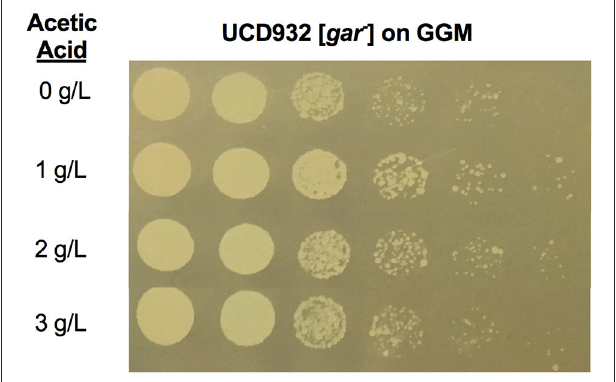
FIGURE 8 | Induction of [ GAR + ] in Saccharomyces by growth in presence of acetic acid is concentration dependent. Growth of Saccharomyces UCD932 [ gar − ] strain when exposed to different levels of acetic acid for 4 h in the selective media, GGM then plated on GGM at 1/5 serial dilutions. Prion induction is higher at 1 and 2 g/L as compared to no acetic acid and higher level of acetic acid as evidenced by the presence of colonies in the final